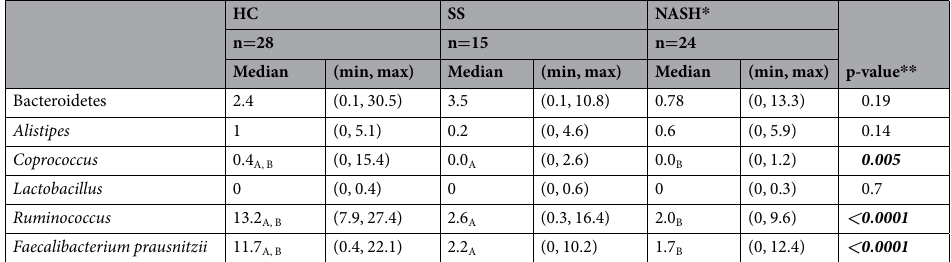
Table 3. Relative abundances of bacterial taxa quantified by quantitative PCR. Abundances were calculated as ratio of colony forming units (CFU) to total bacteria CFU in the sample. Same subscript denotes significant difference (after Bonferroni correction). HC: Healthy controls, SS: simple steatosis, NASH: nonalcoholic steatohepatitis. * For 1 NASH patient there was not enough DNA for Coprococcus, Alistipes and F. prausnitzii, so the sample size was reduced to n = 23. ** Kruskal Wallis test. Same subscript letters denote significant